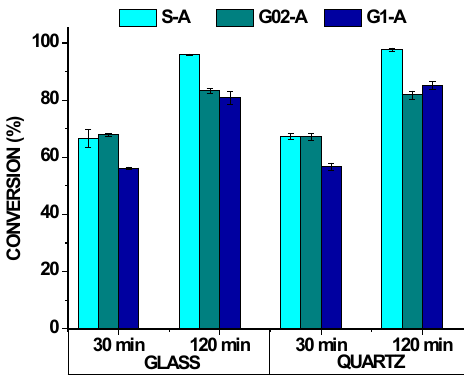
Figure 7. Kinetics of the lactonization of profragrance A under selected conditions using the solar lamp. The experiments were repeated in triplicate and results are expressed as mean ± standard deviation.